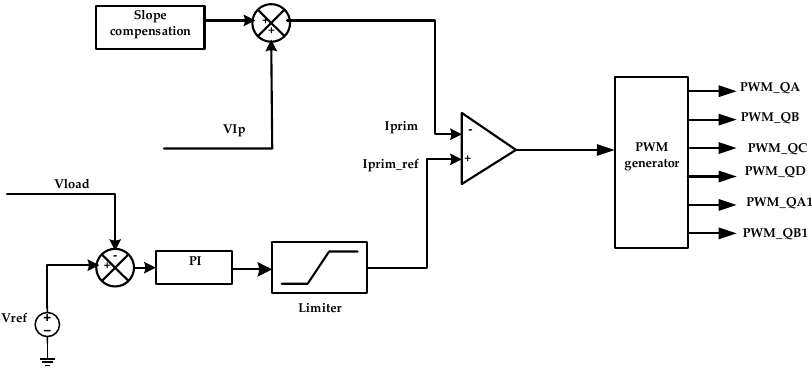
Figure 8. Technique of the phase shift PWM DC–DC converter controller.